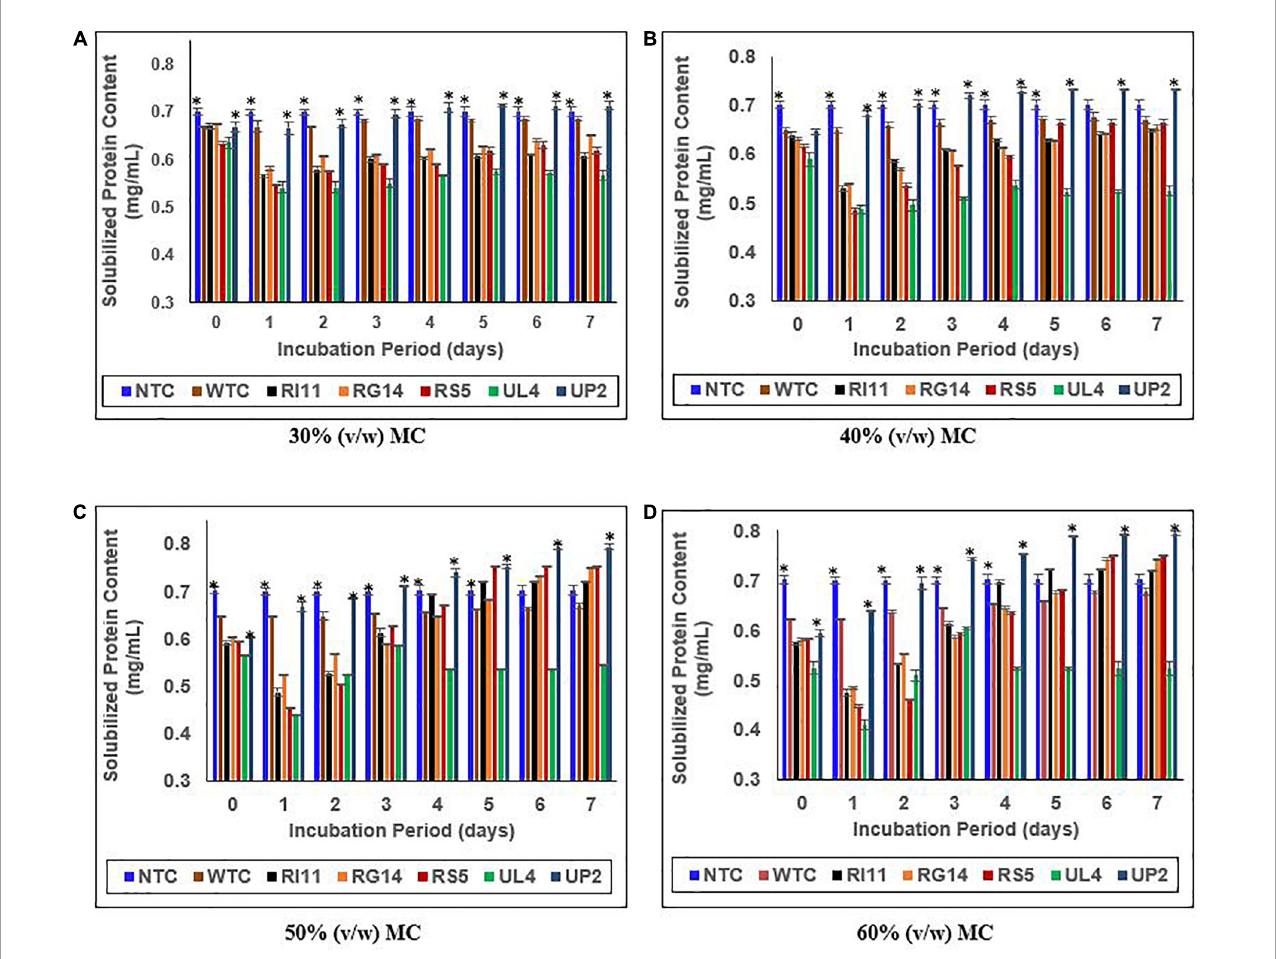
FIGURE4 Effect of moisture contents on the soluble protein content of composite flour during 7 days of solid-state fermentation mediated by probiotic strains. Each value represents mean ± SEM, n = 3. NTC, non-treated control; WTC, water-treated control; R111, L. plantarum RI11; RG14; L. plantarum RG14; RS5, L. plantarum RS5; UL4, L. plantarum UL4; UP2, P. pentosaceus UP2. (A) 30% (v/w) moisture content, (B) 40% (v/w) moisture content, (C) 50% (v/w) moisture content, (D) 60% (v/w) moisture content. ∗ Indicate significant difference ( p ≤ 0.05). ns Not significantly